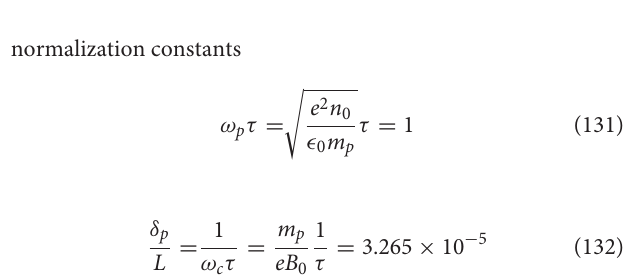
0.5 while the bottom case has the model =